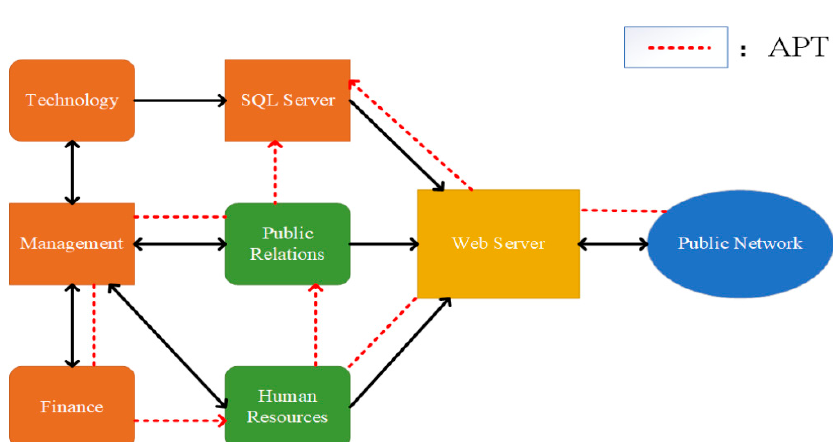
Figure 6. Possible APT paths.